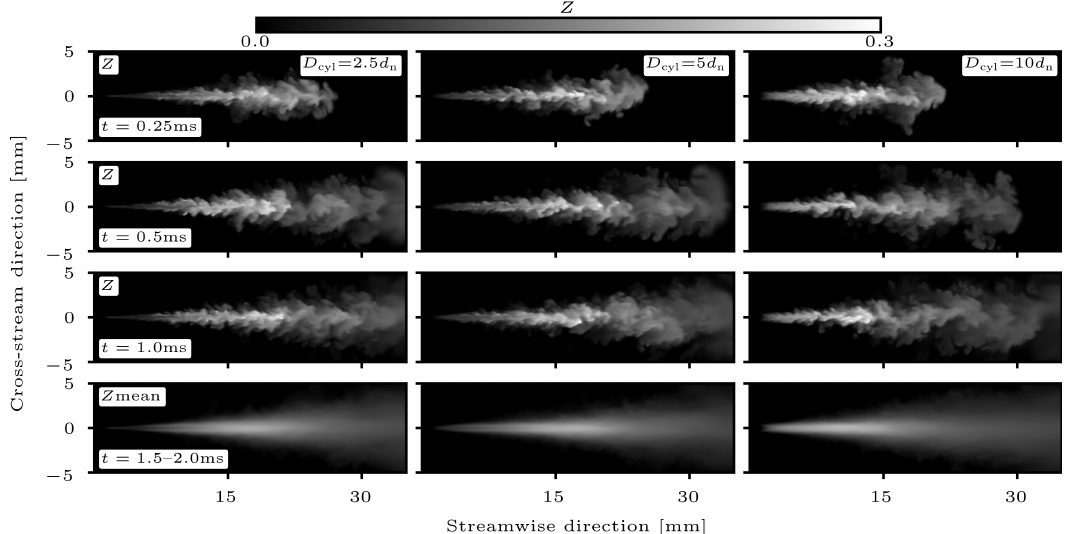
Figure 3. Temporal evolution of mixture fraction ( Z ) for varied D cyl of the injection cylinder, while the total cylindrical injection volume ( V cyl ) is fixed.